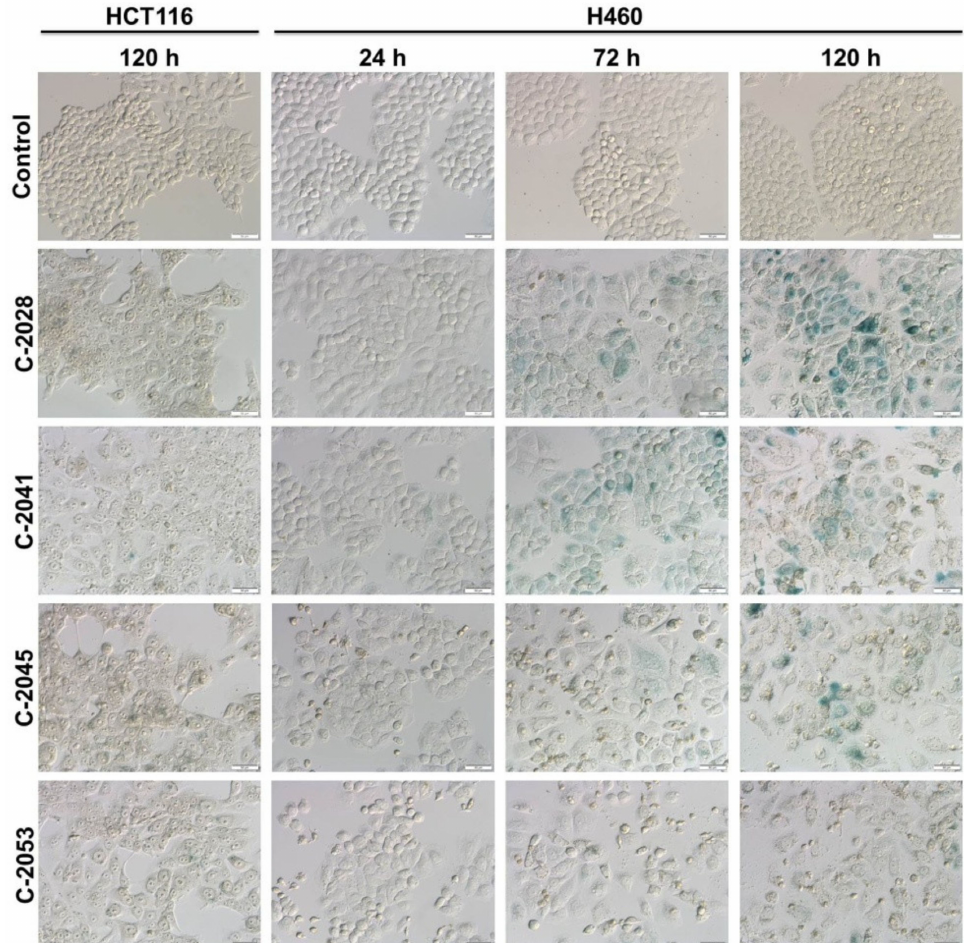
Figure 9. Accelerated senescence induction in HCT116 and H460 cells exposed to UAs derivatives. Representative images of cells examined for senescence associated with β -galactosidase (SA– β –gal) activity are shown. Cells were treated with 0.04, 0.05, 0.4 and 0.2 µ M of C-2028, C-2041, C-2045 and C-2053 compounds, respectively, fixed, stained with X-gal, substrate for SA– β –gal enzyme, and analyzed under a bright-field inverted microscope (magnification × 200). The flattened and enlarged blue-colored cells were considered to be undergoing senescence. White scale bars presented on images correspond to 50 µ m ( n =